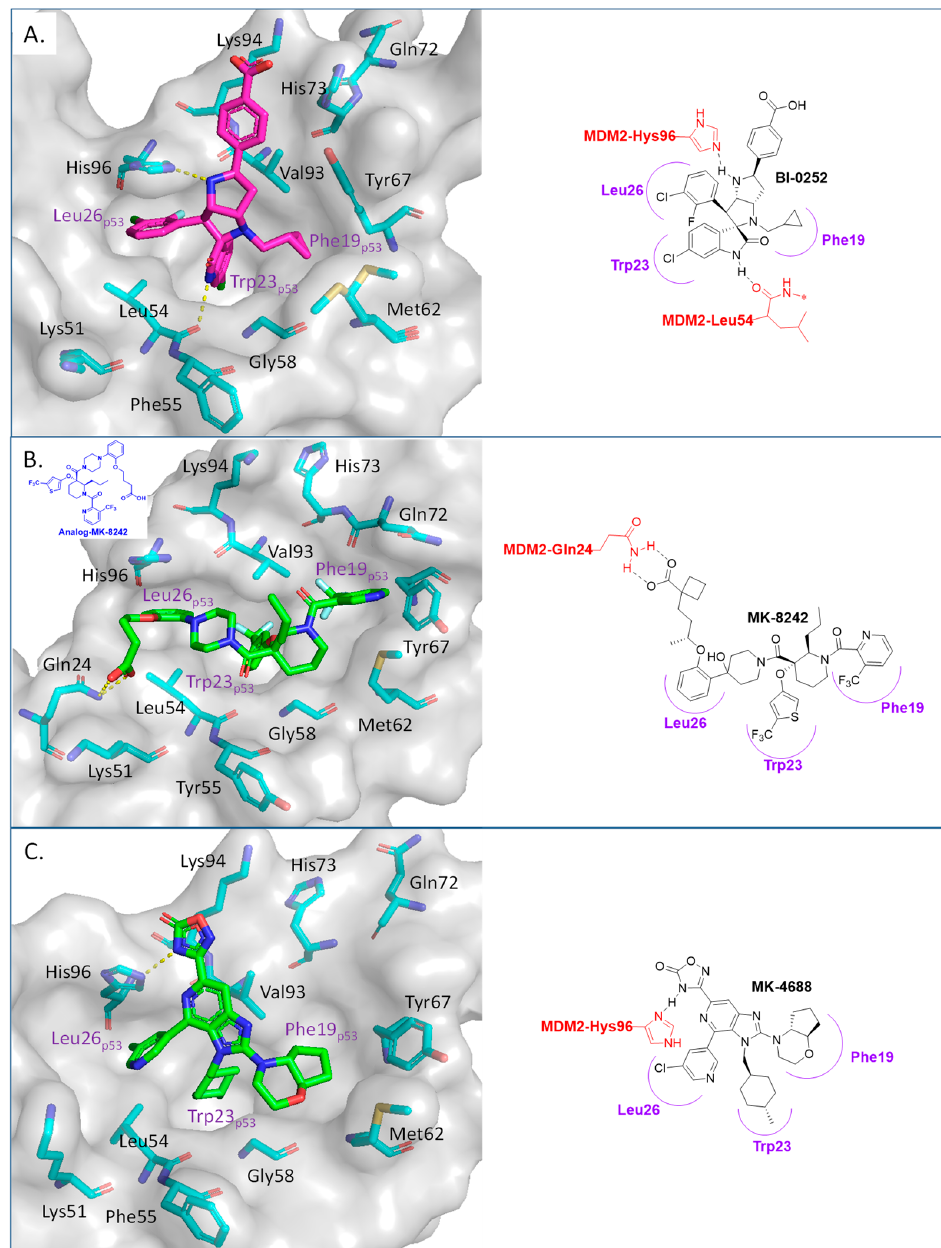
Figure 6. Co-crystal structures and chemical structures of inhibitors bound to MDM2 protein: ( A ) BI-0252; ( B ) MK-8242; ( C ) and MK-4688. Labels and semicircles in magenta indicate the binding pockets in MDM2 where the p53 residues Phe19, Trp23, and Leu26 bind. Labels in red indicate MDM2 residues. MDM2